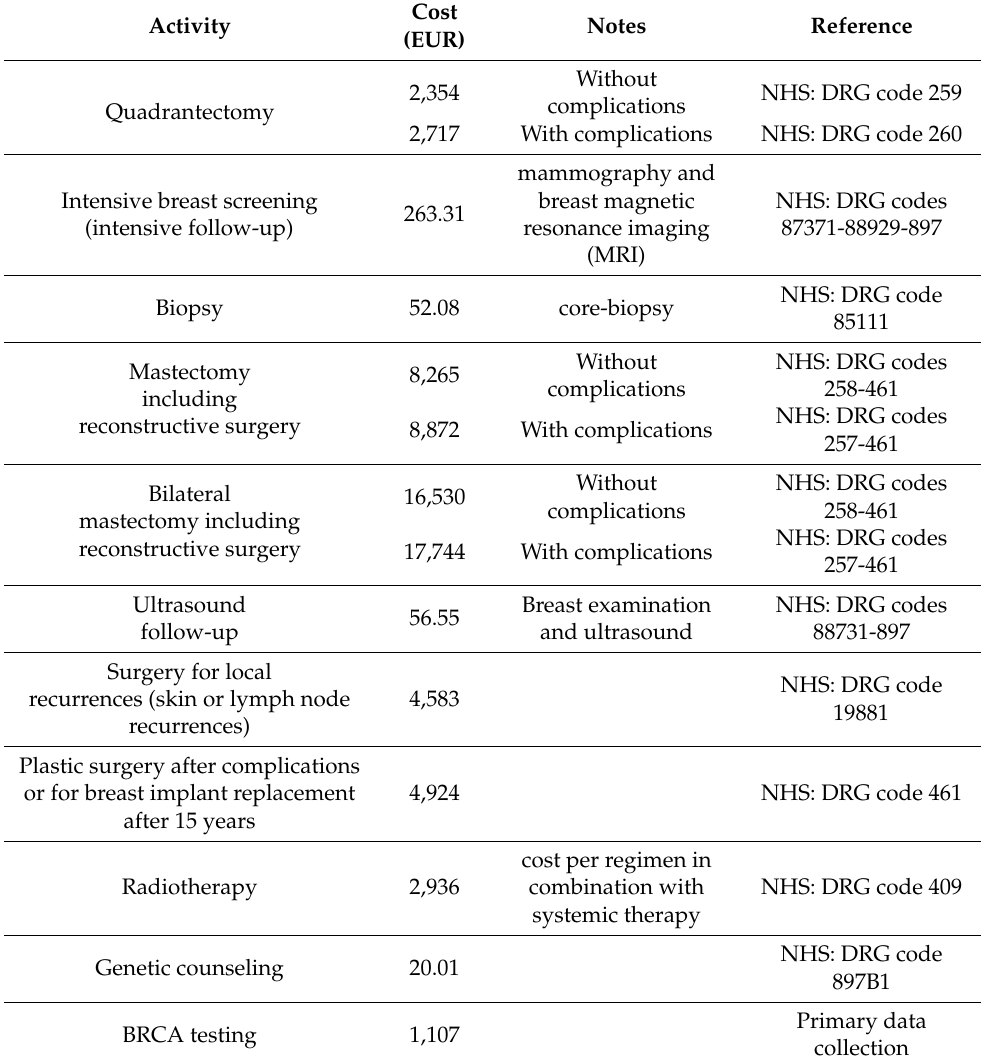
Table 3. Model input parameters: